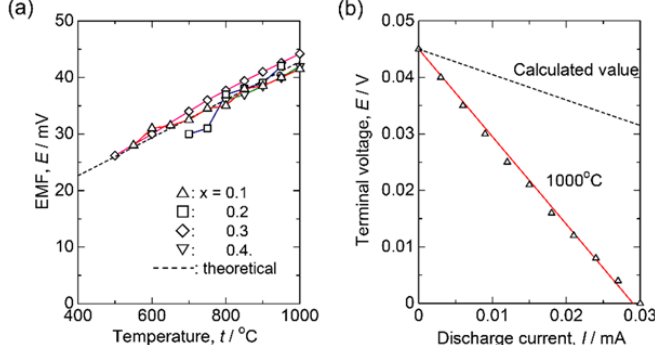
Figure 5. ( a ) EMFs of the oxygen gas concentration cells as follows using Ca 1 − x K x WO 4 − x/2 sample discs as the electrolyte. Air ( P (O 2 ) = 0.21 atm) | Ca 1 − x K x WO 4 − x/2 | O 2 gas ( P (O 2 ) = 0.21 atm). : x = 0.1, : 0.2, : 0.3, and : 0.4. Dashed line denotes the Nernstian value; ( b ) Discharge plot of the oxygen gas concentration cell employing Ca 1 − x K x WO 4 − x/2 ( x = 0.1) measured at 1000 °C. The calculated line was assuming only the ohmic loss.